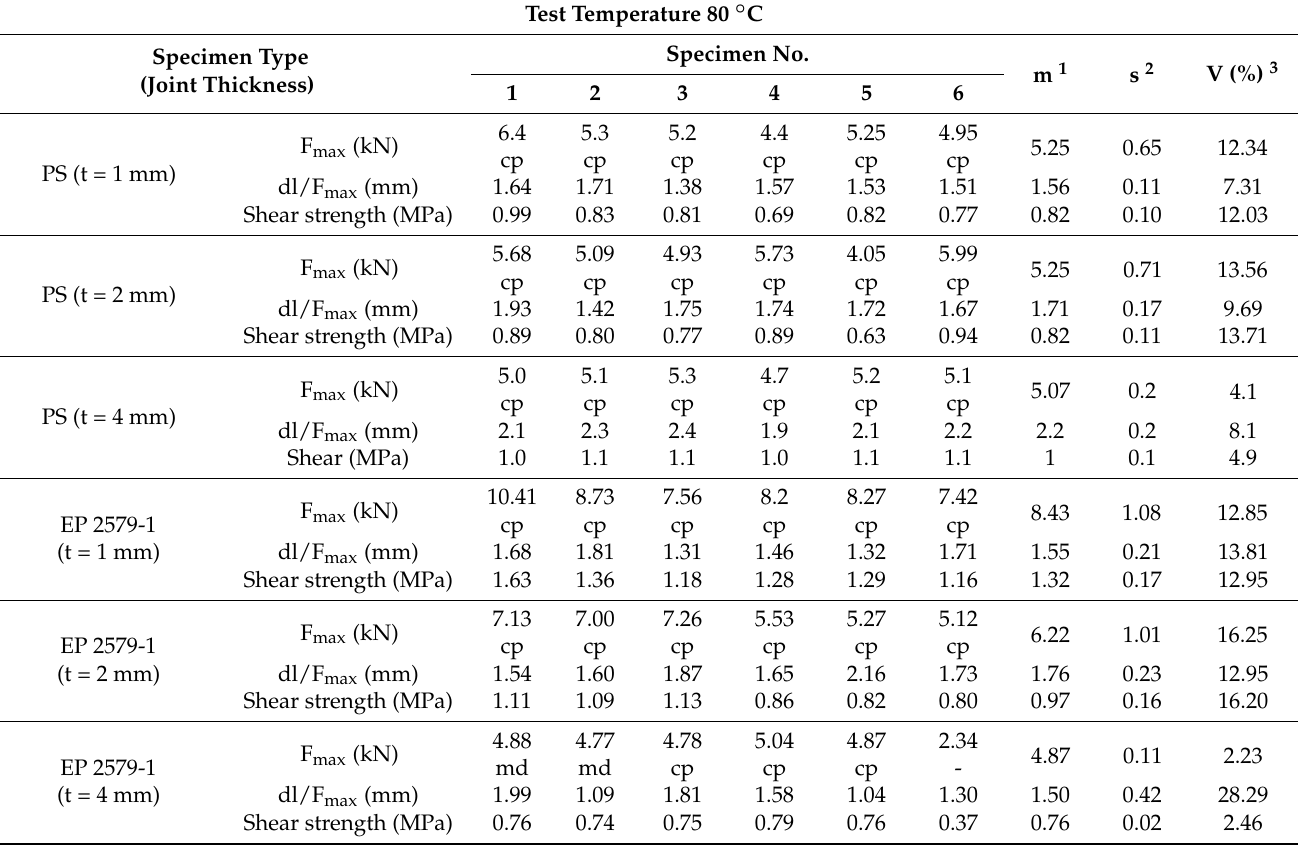
Table 7. Shear test results for the double lap joint during compression at 80 ◦